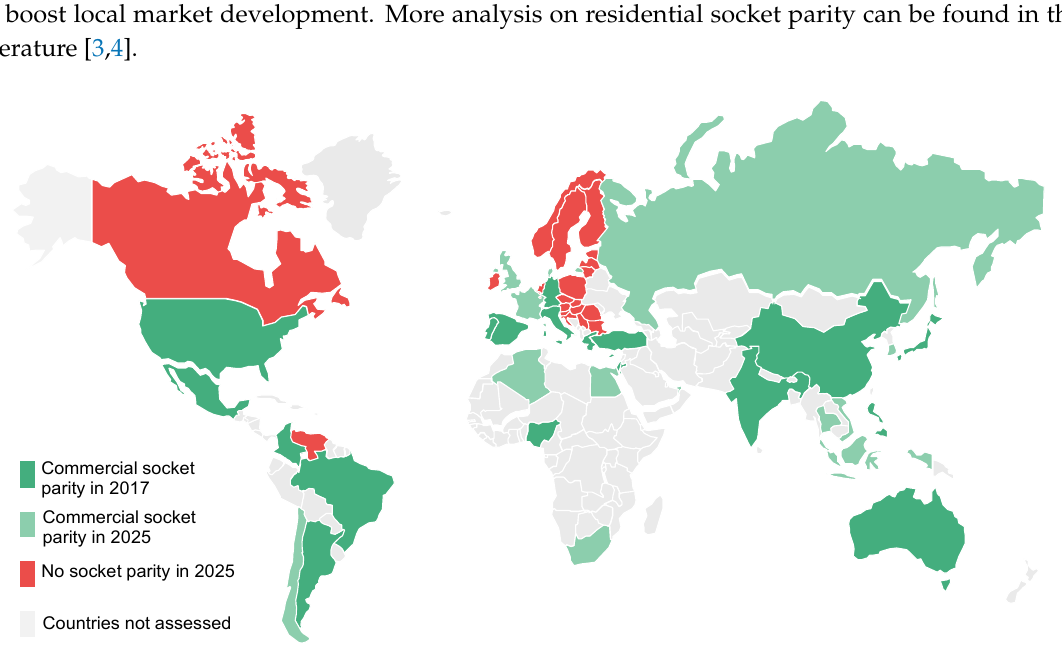
Figure 3. Commercial PV socket parity in 2017 and 2025 with 75% on-site consumption. Note: Generation-based subsidies (in terms of $/kWh) are excluded in the calculation.